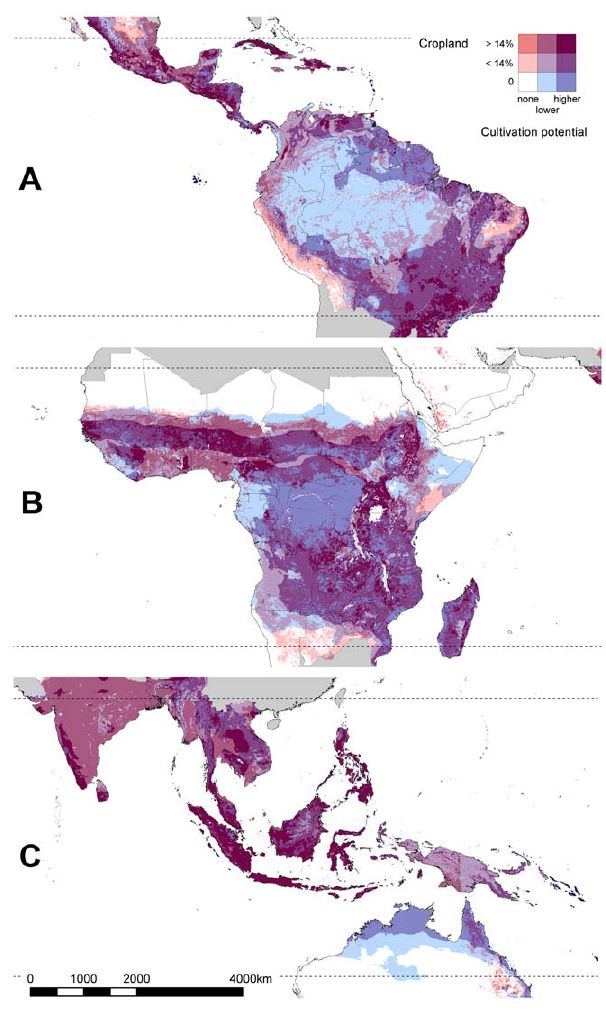
Figure 6. Areas of land with cultivation potential (blue) in relation to current cropland (red). This is illustrated for (A) Neotropical countries, (B) tropical Africa and (C) tropical Asia/Australia. Shades of blue indicate cultivation potential for the crop for which each 5-min grid cell is most suitable. Cultivation potential is calculated as the ‘‘agro-climatically attainable yield’’ for 12 major tropical crops as a percentage of the global maximum for that crop [55]. Shades of red indicate cropland extent in the year 2000, from [5]. The darker shades indicate values above the median. Land which is suitable for one or more crops, and which is already cultivated, is mapped in shades of purple. Land with no cultivation potential for these crops, and no cropland, is mapped in white, and land outside tropical countries is shaded grey.